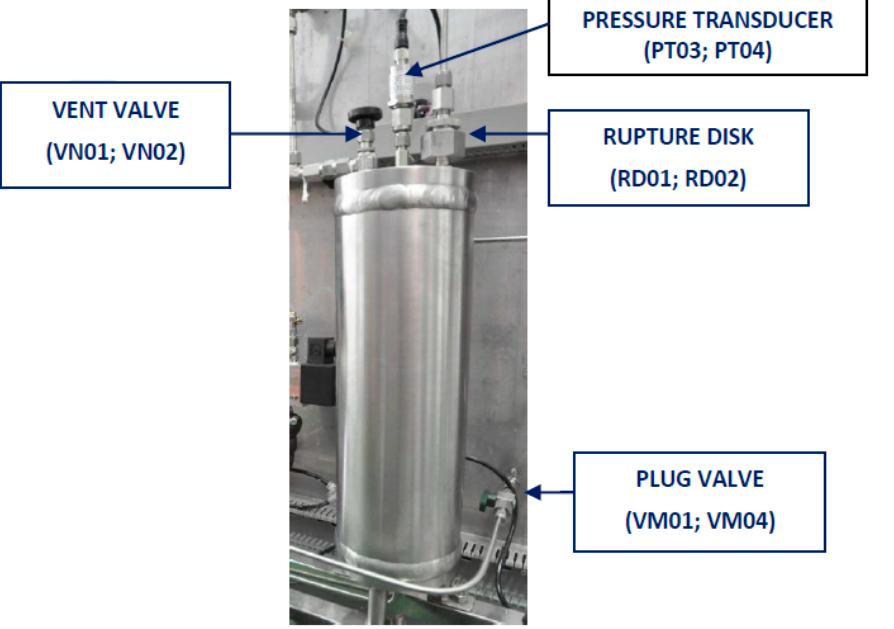
Figure 6. Vessels used to storage the gases (N 2 and CH 4 ) before entering the reactor. VN01 and VN02—storage vessels vent valve; PT03 and PT04—pressure transducer for pressure control; RD01 and RD02—safety rupture disk; VM01 and VM04—plug valve for gas inlet.